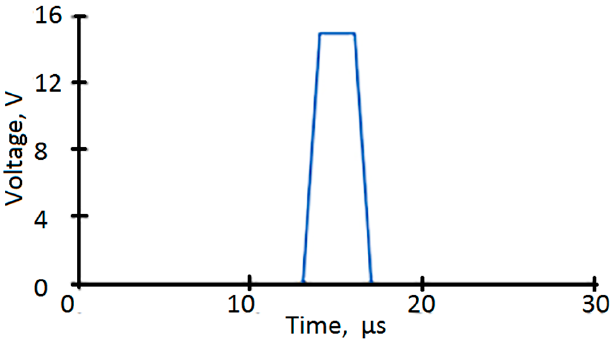
Figure 1. The waveform used for intra-volumetric printing.